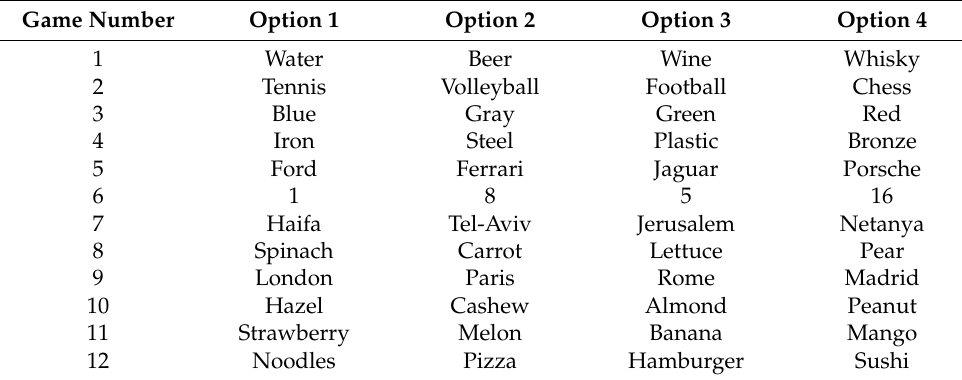
Table A1. Tacit coordination game list.